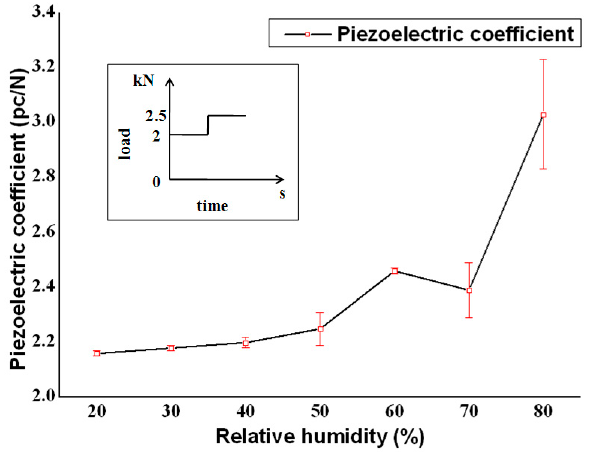
Figure 2. The piezoelectric coefficient dependence of RH.